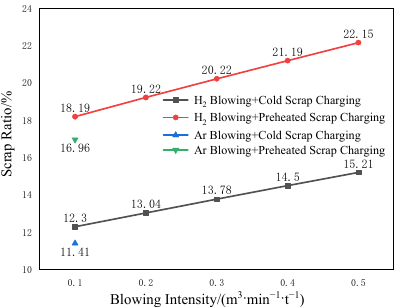
Figure 3. Influence of hydrogen injection intensity and scrap preheating on the charging amount of scrap .